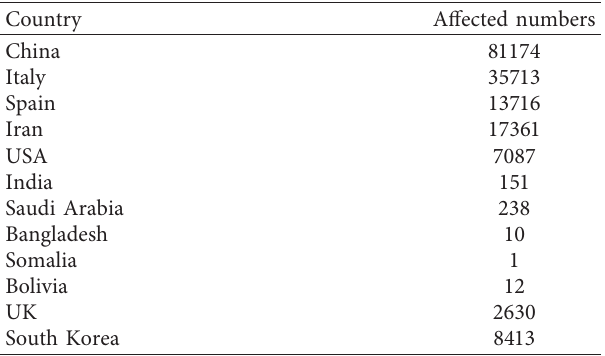
Figure 1: Distribution of COVID-19 cases as of 19 March 2020 [2]. Table 1: Number of infected people by country as of 19 March 2020 Table 2: Fuzzy linguistic variables and [3] considered in this work.